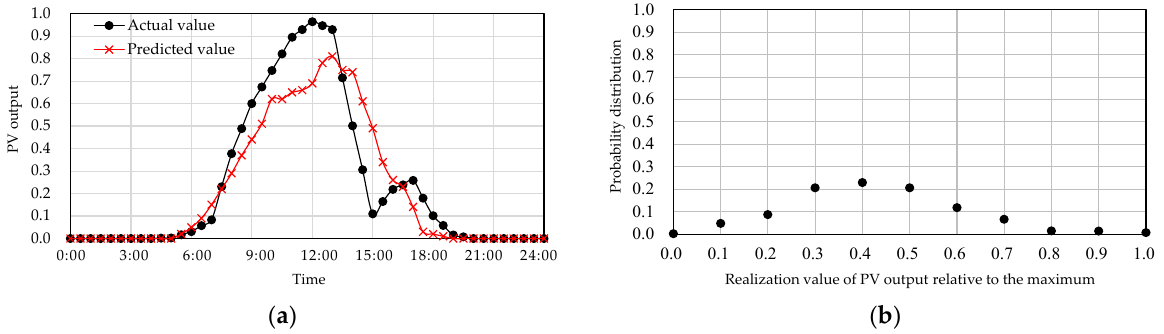
Figure 7. PV output and its probability distribution: ( a ) sample of actual and predicted PV outputs; ( b ) probability distribution for assumed PV output (55% of PV capacity).